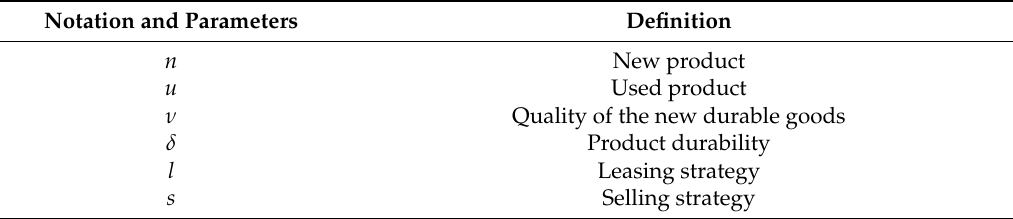
Table 1. The major notations and